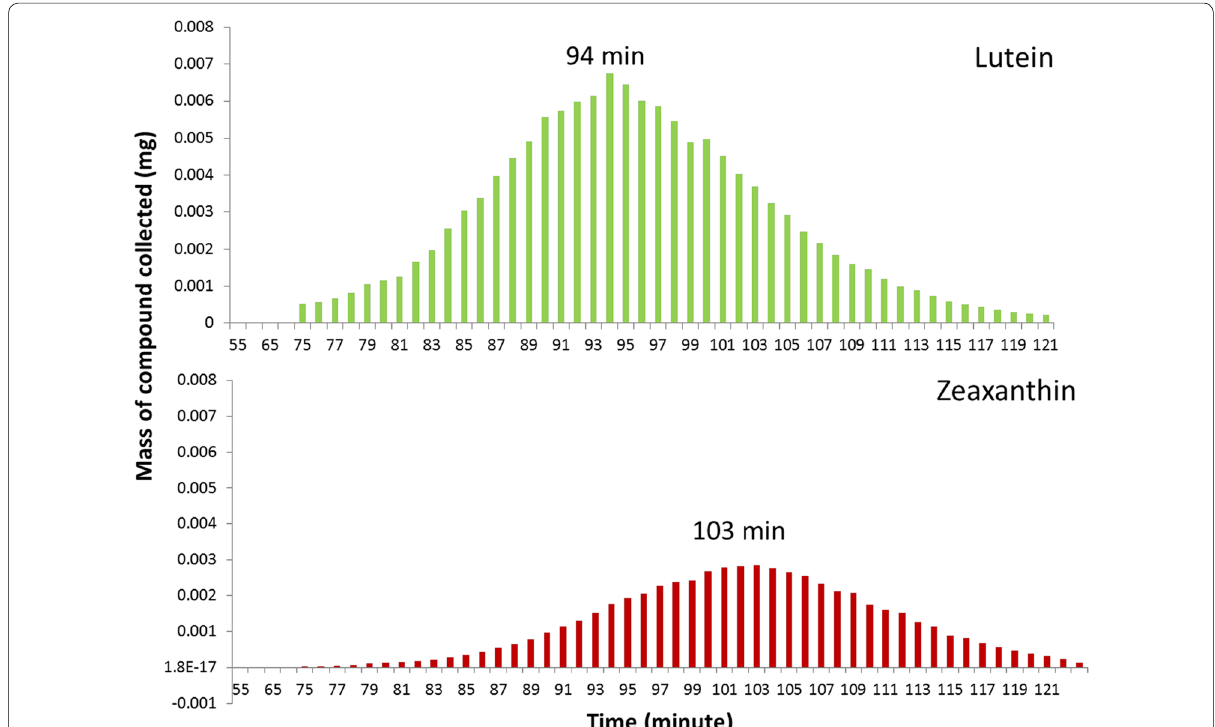
Fig. 2 Elution profile of lutein and zeaxanthin fractions from CPC purification. A fraction was collected each minute and analyzed via HPLC. The highest quantity of lutein and zeaxanthin collected in the fraction was achieved at 94 min (0.0067 mg) and 103 min (0.0029 mg),